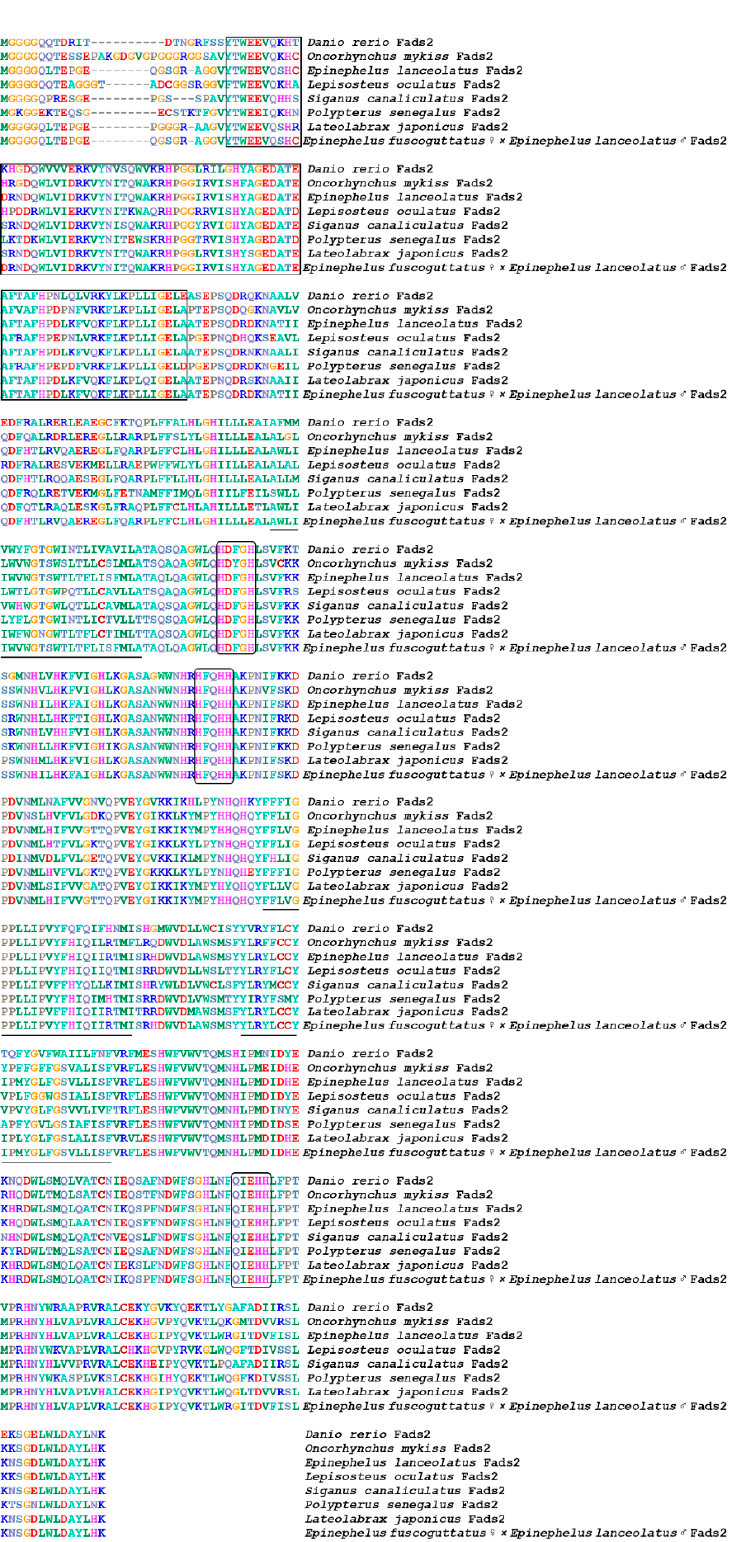
Figure 3. Multiple amino acids sequence alignment of Fads2 from different species. The transmem- brane region of amino acids is represented by a straight line; the conserved motif is marked with a square; the histidine box is marked with an ellipse, and endoplasmic reticulum signal is marked with a double line.